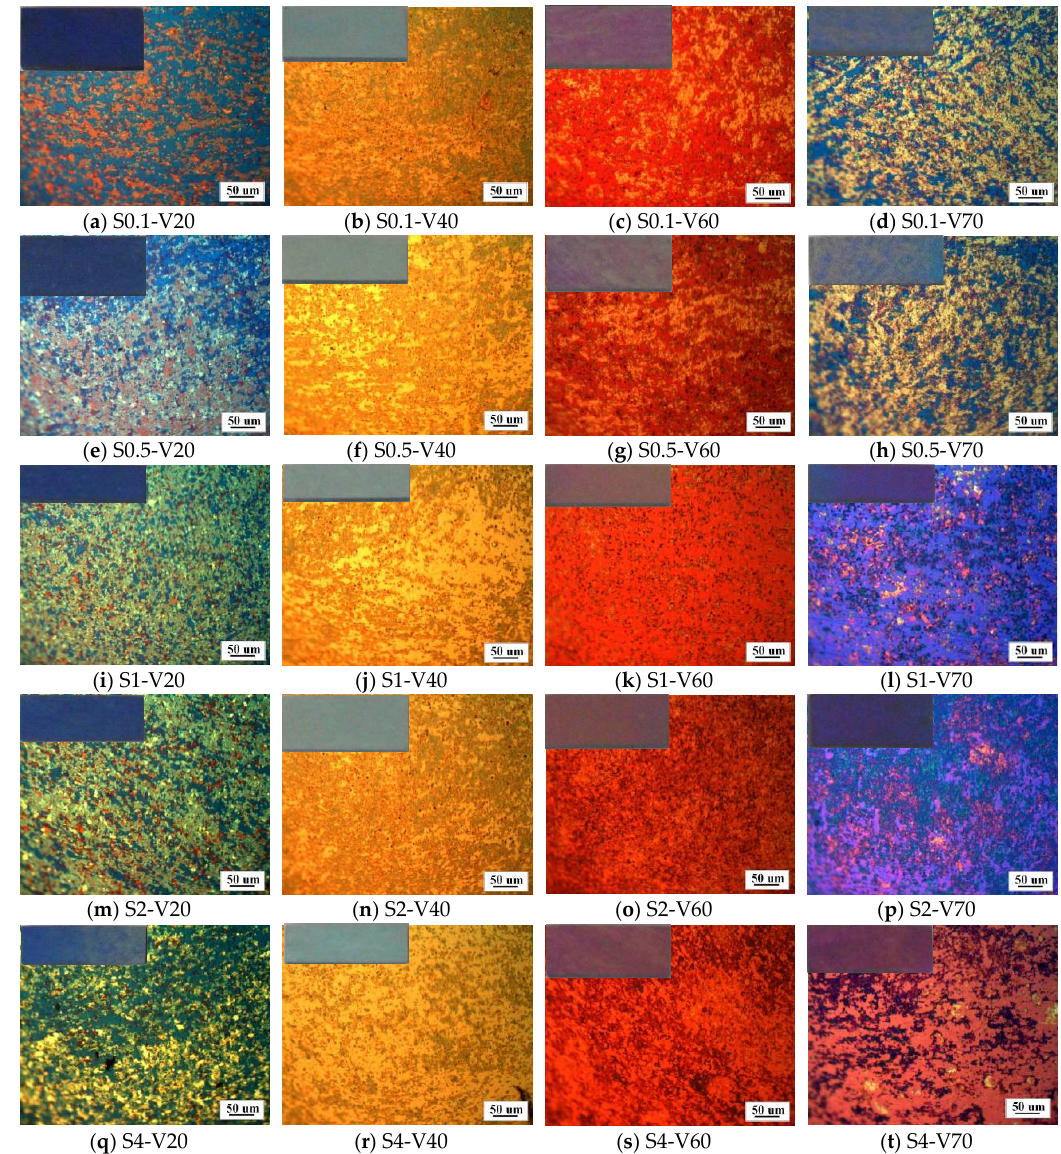
Figure 2. Macrographs (insets) and micrographs of anodic oxidized samples.